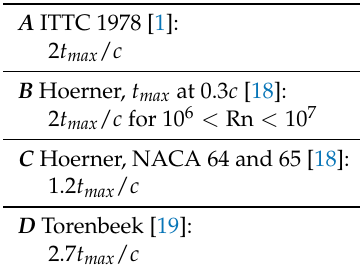
Table 3. Values for the relative form drag ∆ c F / ( 2 c F ) for symmetrical section profiles mentioned in the literature. For the NACA 64 and 65 laminar profiles, the transition point was fixed at 0.09 c . Hoerner also emphasised that the given relationship for these sections are only valid for rough surfaces [18].